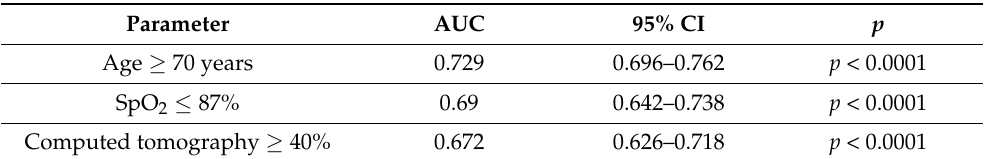
Table 6. Receiver operating characteristics analysis of demographic and laboratory parameters of in-hospital mortality of patients with COVID-19.